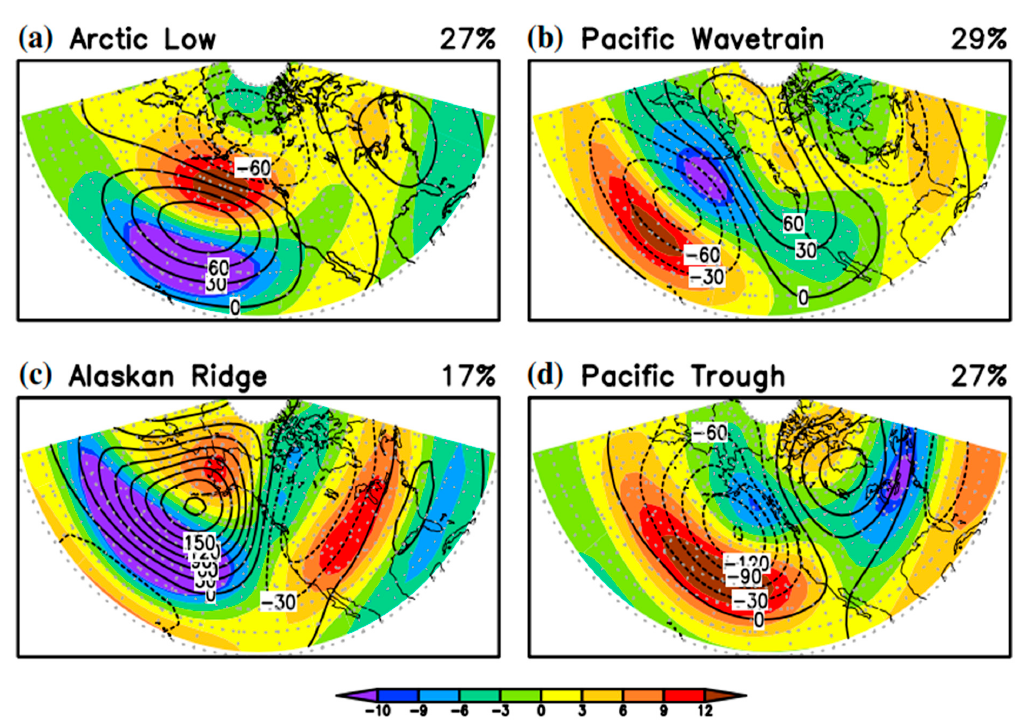
Figure 1. Pacific cluster patterns from Amini and Straus (2019) of the combined 500 hPa geopotential height and 250 hPa zonal wind anomalies resulting in four patterns. Anomalies of Z500 are given in contours (interval 30 m) and U250 are given in shading (units ms − 1 ). The four patterns are defined as ( a ) Arctic Low, ( b ) Pacific Wave-Train, ( c ) Alaskan Ridge, and ( d ) Pacific Trough. The numbers in the upper right corner give the relative frequency of occurrence. The figure is from Amini and Straus [12] and is used with permission.